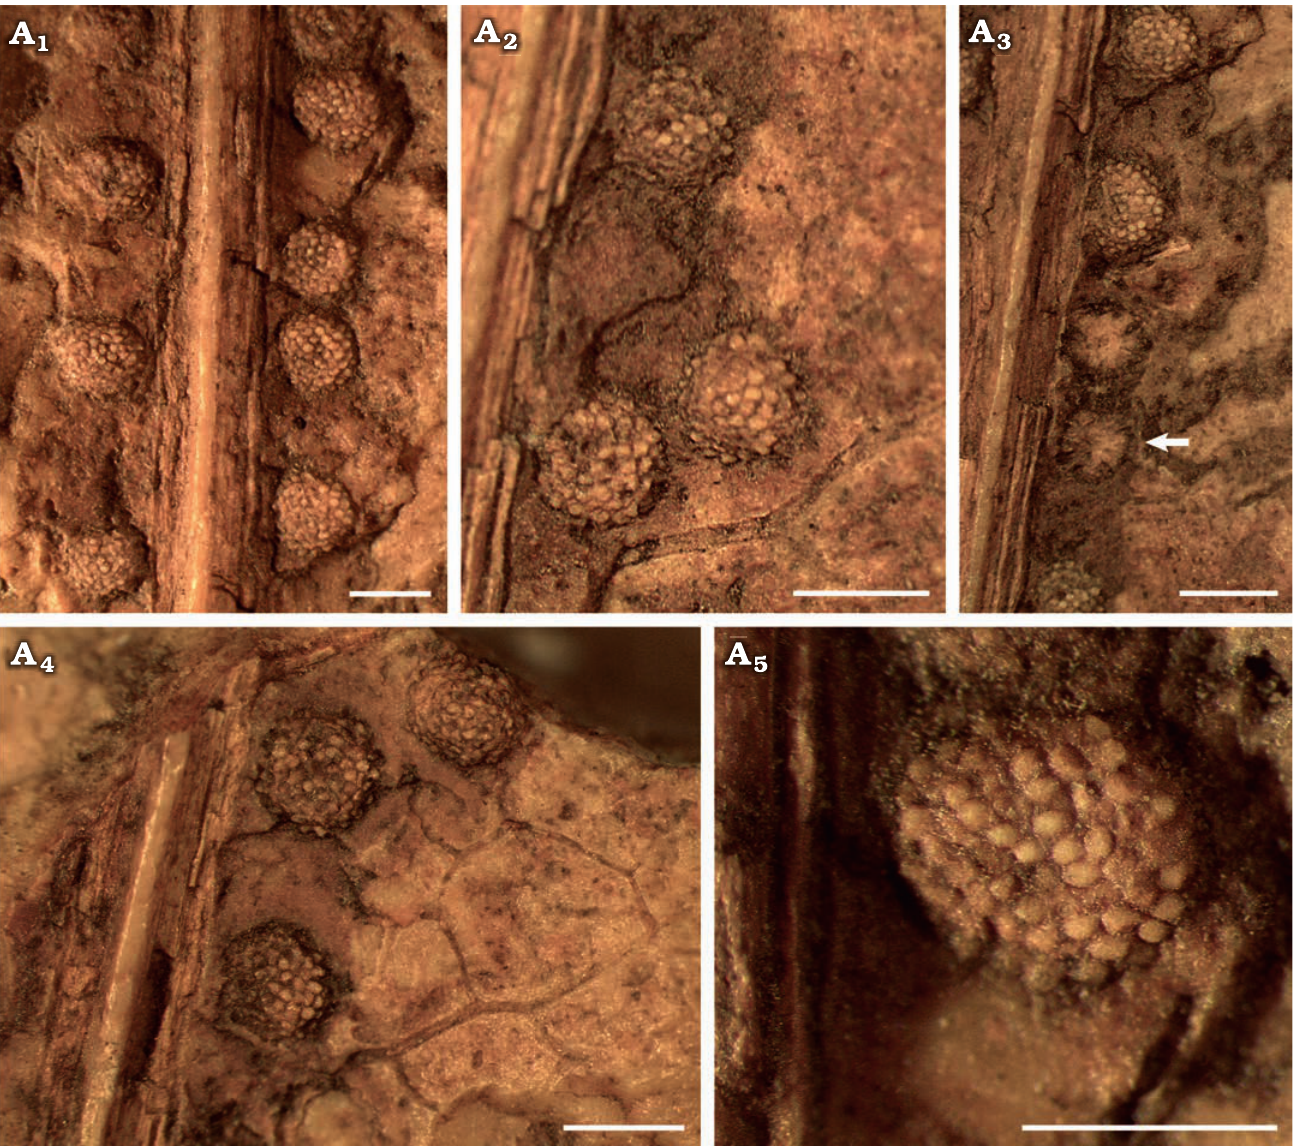
Fig. 7. Dipteridacean fern Patagoniapteris artabeae gen. and sp. nov. from the upper Norian–Rhaetian, Upper Triassic Paso Flores Formation, Neuquén Province, Argentina. A . MCF-PBPH 066, view of the sori. A 1 –A 5 , details of the sori with and without sporangia (arrow). Scale bars 1.5 mm.